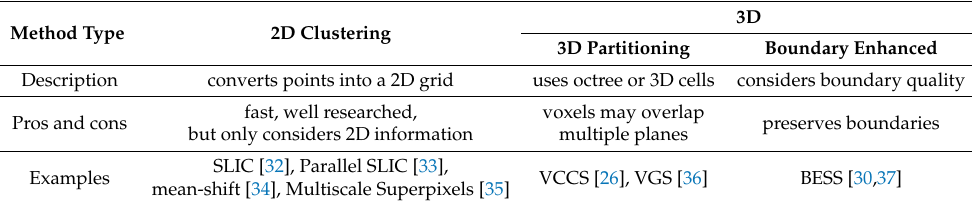
Table 1. The categories of voxel clustering